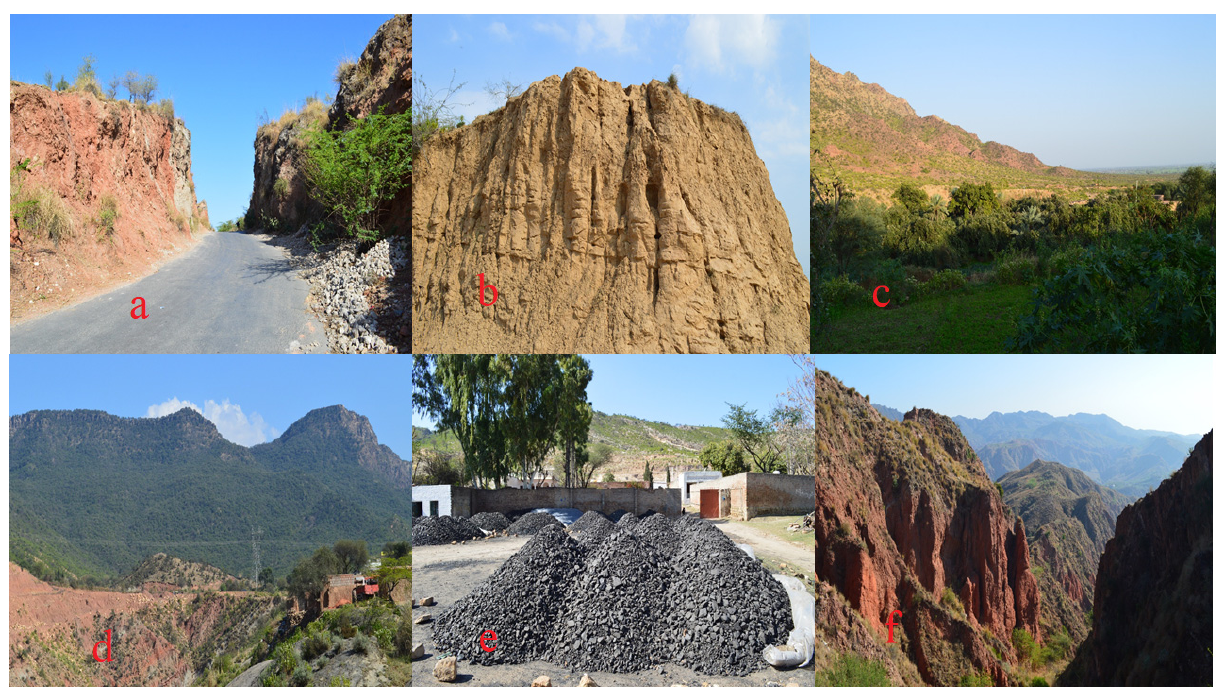
Figure 2. View of different land cover types in Jhelum District showing diverse LULC: ( a ) road in the mountains representing a new built-up area in 2020; ( b ) barren land (sandy dune cutting), another important LULC category in the area; ( c ) vegetation cover; ( d ) anthropogenic activities affecting LULC variations; ( e ) deforestation affecting vegetation cover; ( f ) natural disturbance causing LULC